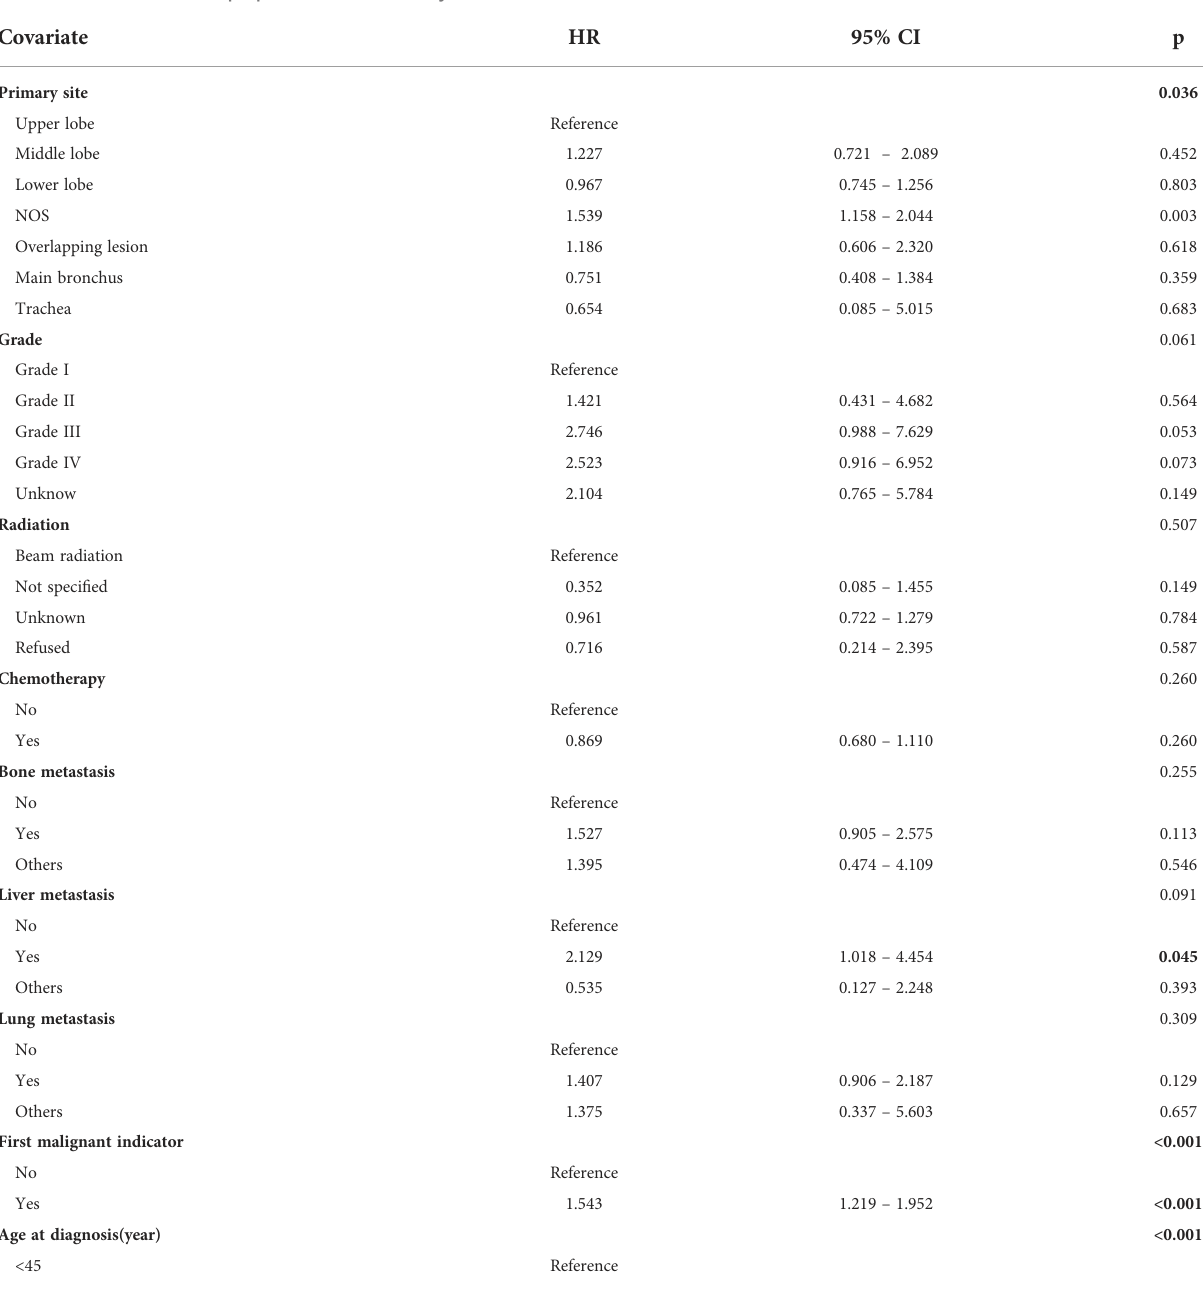
TABLE 2 Multivariable Cox proportional hazards analysis of OS in PSC